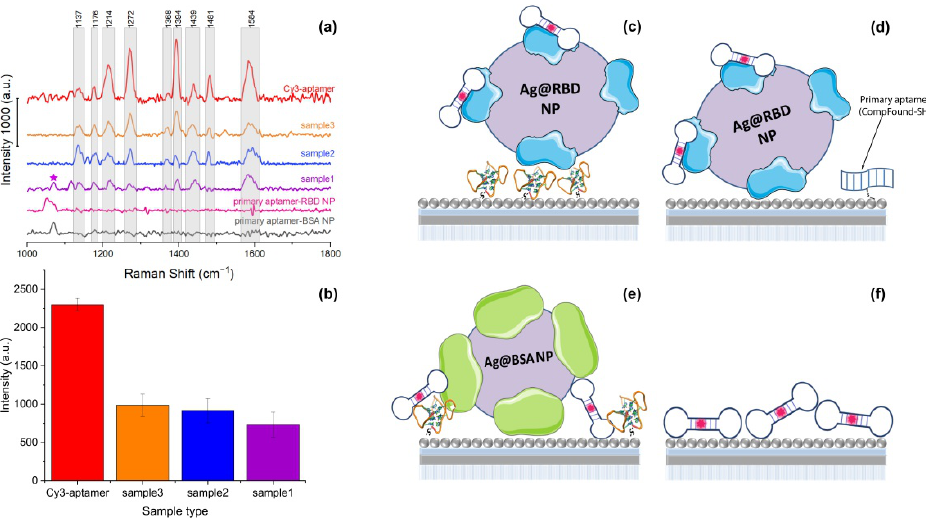
Figure 5. ( a ) SERS spectra of the Cy3-labeled secondary aptamer (red), Sample 3 (yellow), Sample 2 (blue), Sample 1 (violet), primary aptamer-RBD NPs (pink), primary aptamer, and BSA NPs mixture (black) on the obtained hybrid plasmonic substrate. ( b ) SERS signal at 1272 and 1394 cm − 1 for Cy3-labeled aptamer, Sample 1, Sample 2, and Sample 3. Scheme of the distribution of ( c ) Sample 1, ( d ) Sample 2, ( e ) Sample 3, and ( f ) Cy3-labeled secondary aptamer on an SERS-active hybrid